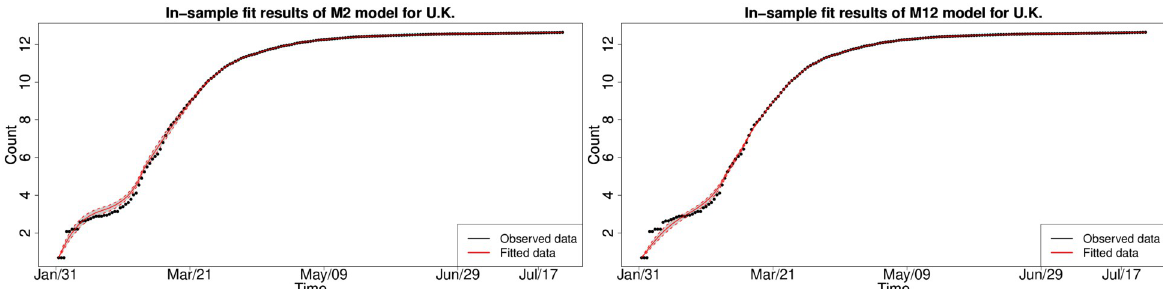
Fig 6. In-sample fit results for the UK for the period January 2020—August 2020. In-sample fitted plot (y-axis in log scale) for the UK by Model 2 (baseline, left) and Model 12 (best, right) (January 2020—August 2020).